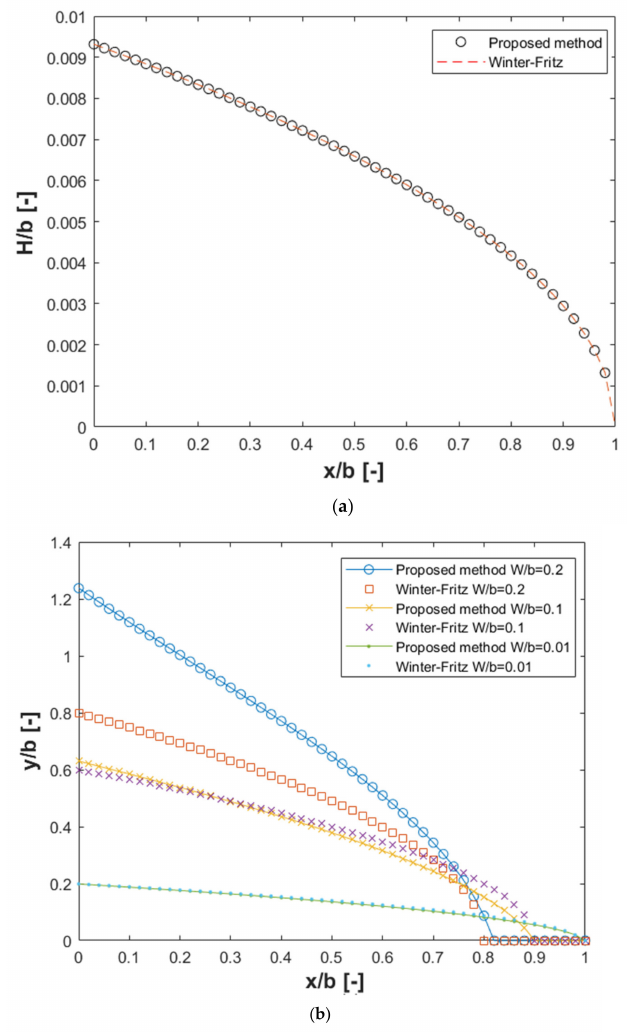
Figure 11. ( a ) Change of normalized design parameter H with respect to normalized x and ( b ) change of normalized design parameter y with respect to normalized x for power-law polypropylene (parameters in Table 1) having a rectangular manifold with constant W/b ratio, ( W/b = 0.01, 0.1 and 0.2, N =